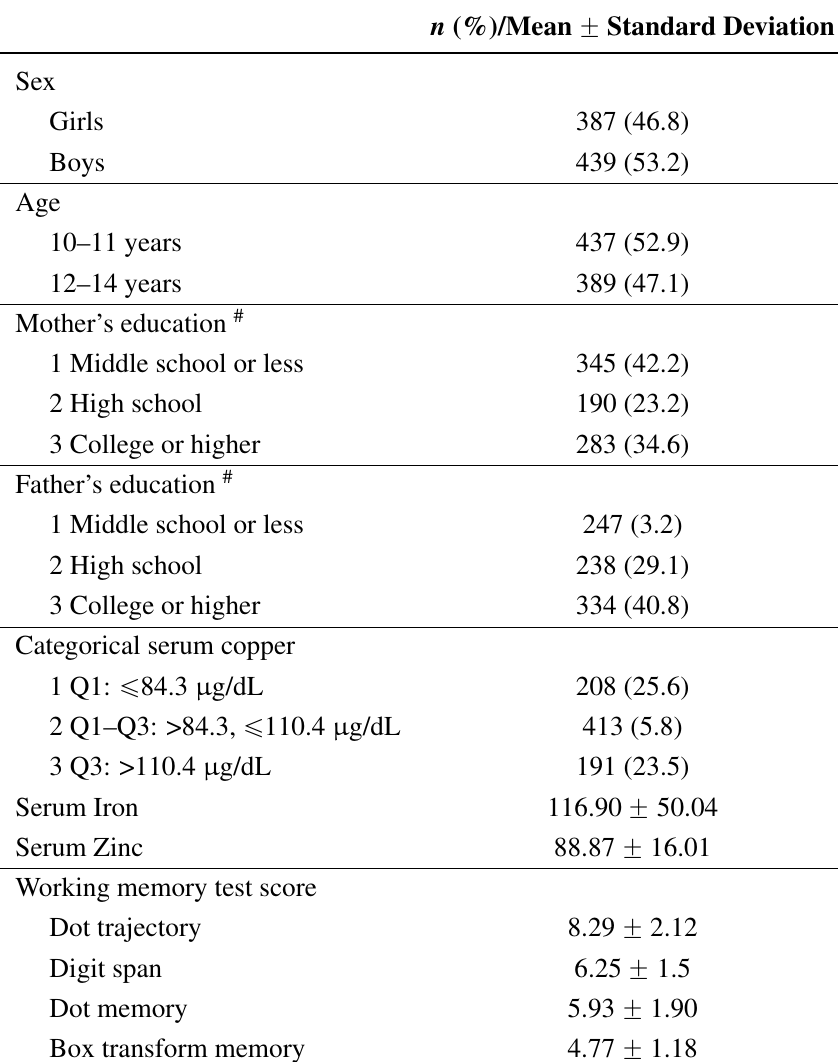
Table 1. Sociodemographic characteristics and descriptive statistics of single working memory test